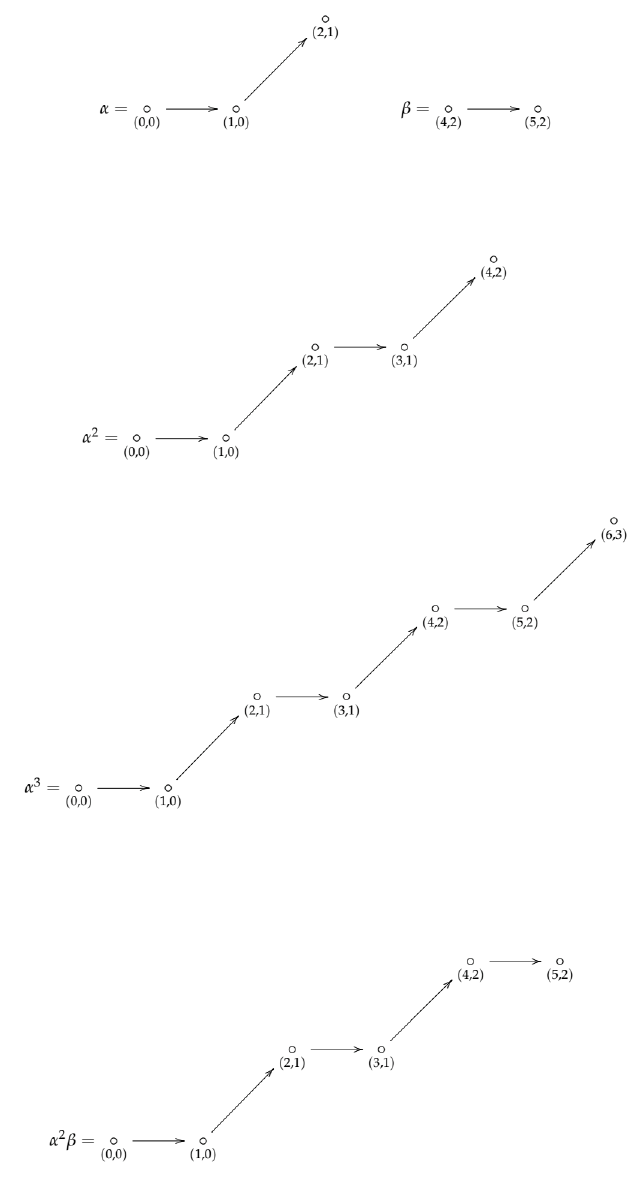
Figure 5. Examples of admissible paths with ( 0,0 ) and ( 4,2 ) as starting